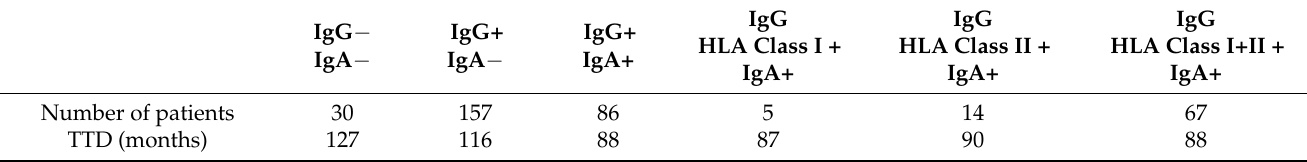
Table 3. Time-to-dialysis (TTD) in patients with allograft failure and anti-HLA IgG specificity, combined with anti-HLA